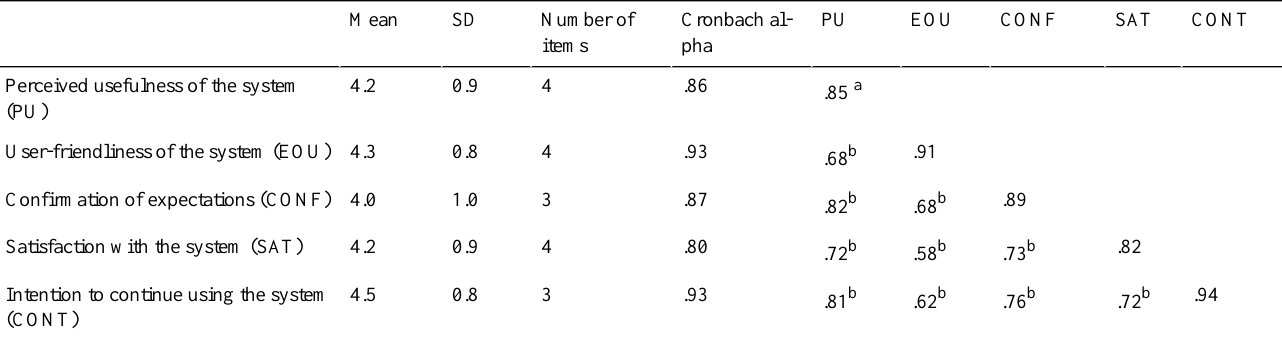
Table 3. Descriptive statistics and variance shared by the